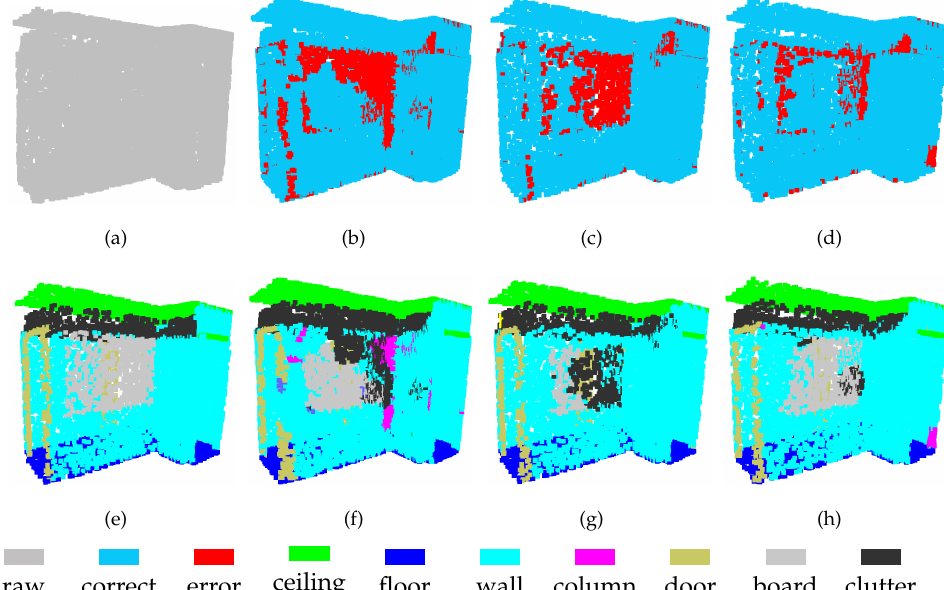
Figure 6. Segmentation results on the S3DIS-3 dataset: ( a ) input, ( e ) ground truth, ( b , f ) Level-1, ( c , g ) Level-2, and ( d , h ) MSSCN.